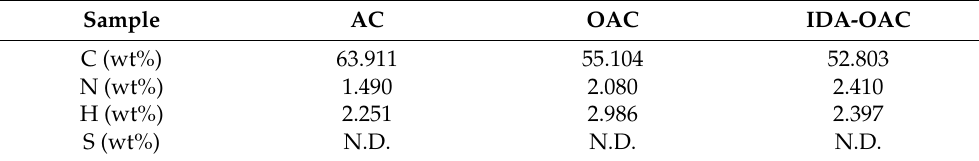
Table 1. Element analysis of AC, OAC, and IDA-OAC.